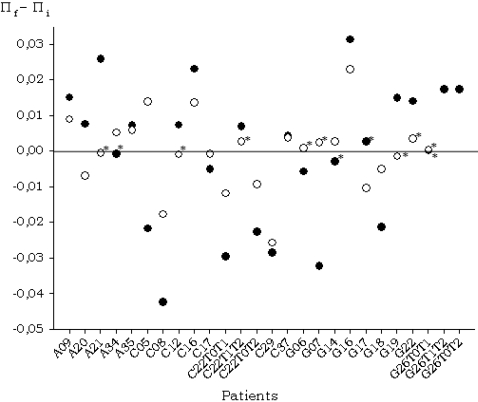
Graphic representation of the differences in nucleotide diversity between final versus initial time samples for the E1-E2 and NS5A regions (denoted as black and white dots, respectively).Three time samples were obtained for patients C22 (for E1-E2 and NS5A regions) and G26 (for E1-E2 region) and, consequently, differences between these three time samples are represented. Non-significant differences are indicated with an asterisk.